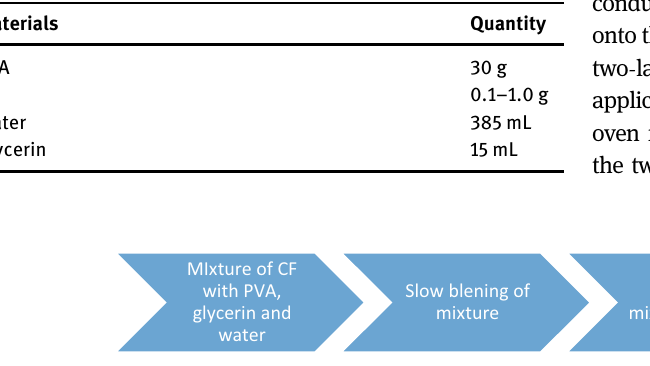
Table 1: Experiment materials quantity for PVA - CF Materials